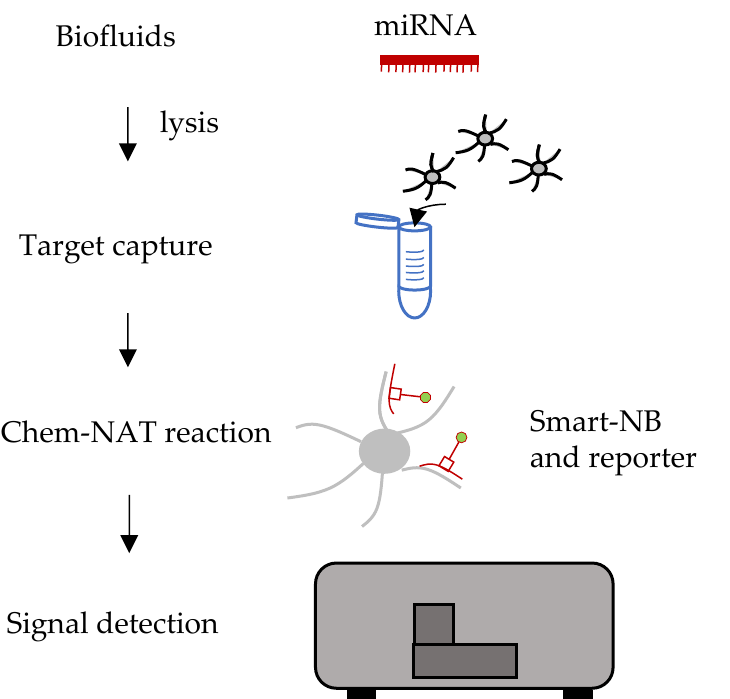
Figure 11. Diagram of Chem-NAT workflow. Chem-NAT allows direct detection of the analyte of interest. First, the probes (in the example coupled to magnetic beads) are injected directly in the sample of interest together with a proper lysis buffer. Second, the Chem-NAT reaction occurs, by specific incorporation of the SMART-NB modified with a reporter. Finally, the signal produced by the reporter is